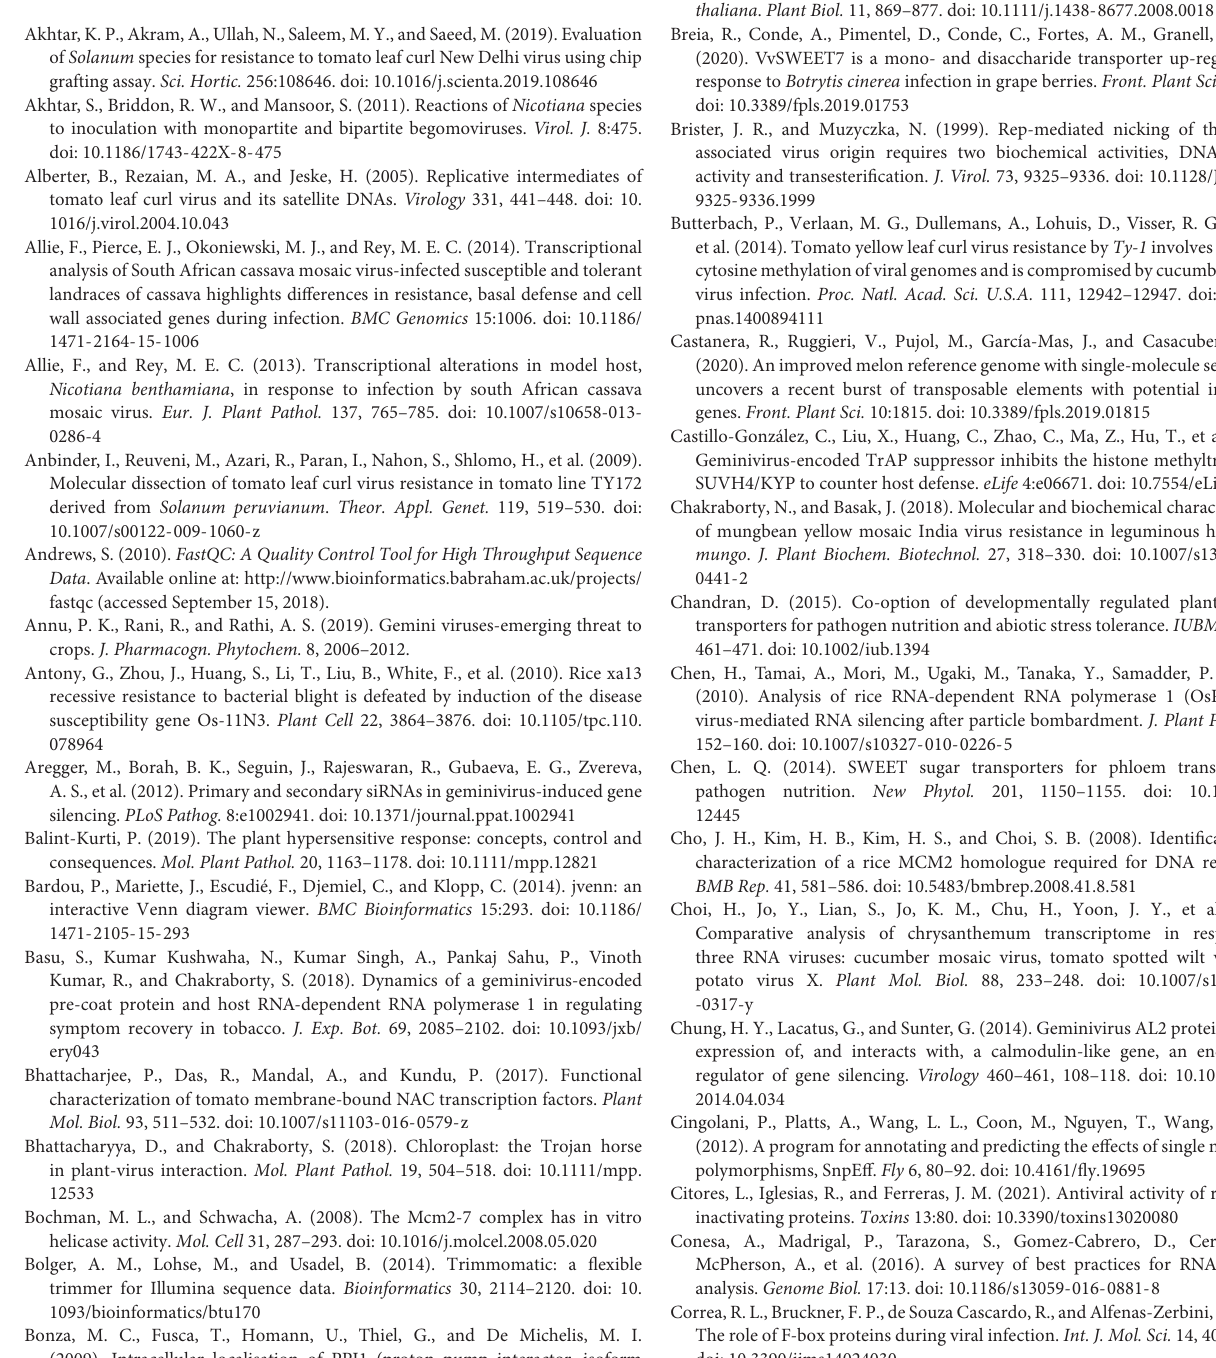
Supplementary Table 11 | List of polymorphic transcript-based SNPs between WM-7 and PS with both alleles fixed in homozygosity. SNP position, reference and alternative alleles, genotype for each sample, affected genes, and putative impact of the SNP on the gene structure are shown. The reference allele is represented as 0 and the alternative allele as 1. Cells highlighted in yellow refer to DEGs. Horizontal lines in chromosomes 2, 11, and 12 delimit candidate regions considered in this study for ToLCNDV